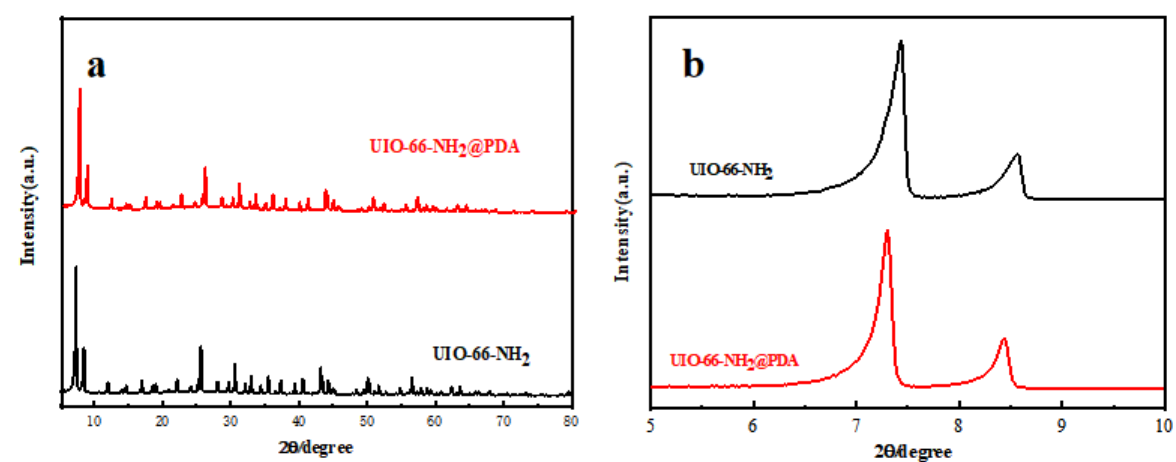
Figure 2. ( a ) XRD patterns of UiO-66-NH 2 and UiO-66-NH 2 @PDA; ( b ) low-angle XRD patterns of UiO-66-NH 2 and UiO-66-NH 2 @PDA .